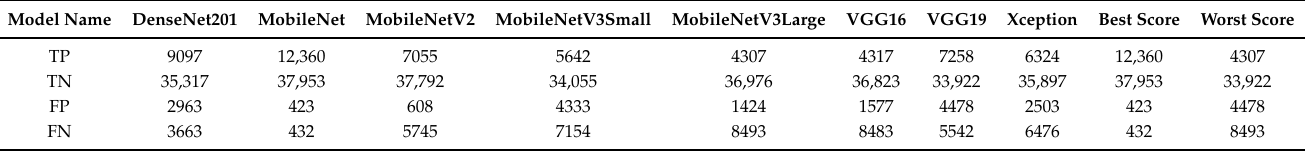
Table 3. The confusion matrix (i.e., TP, TN, FP, and FN) for each pretrained CNN model using the “Alzheimer’s Dataset (4 class of Images)” dataset.